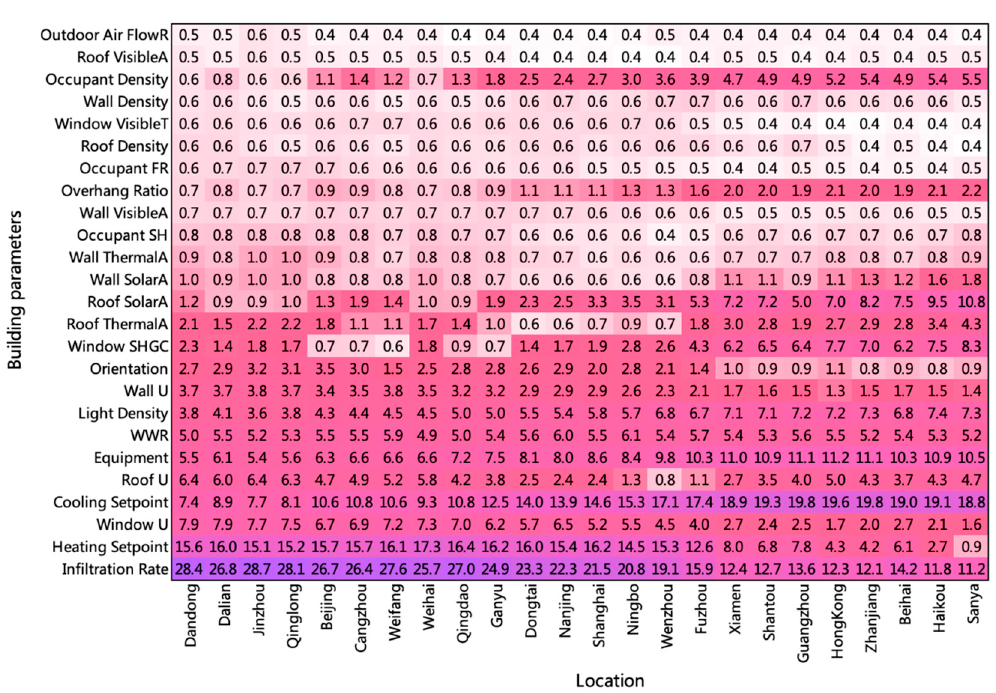
Figure 7. PI of input parameters in annual building energy consumption.